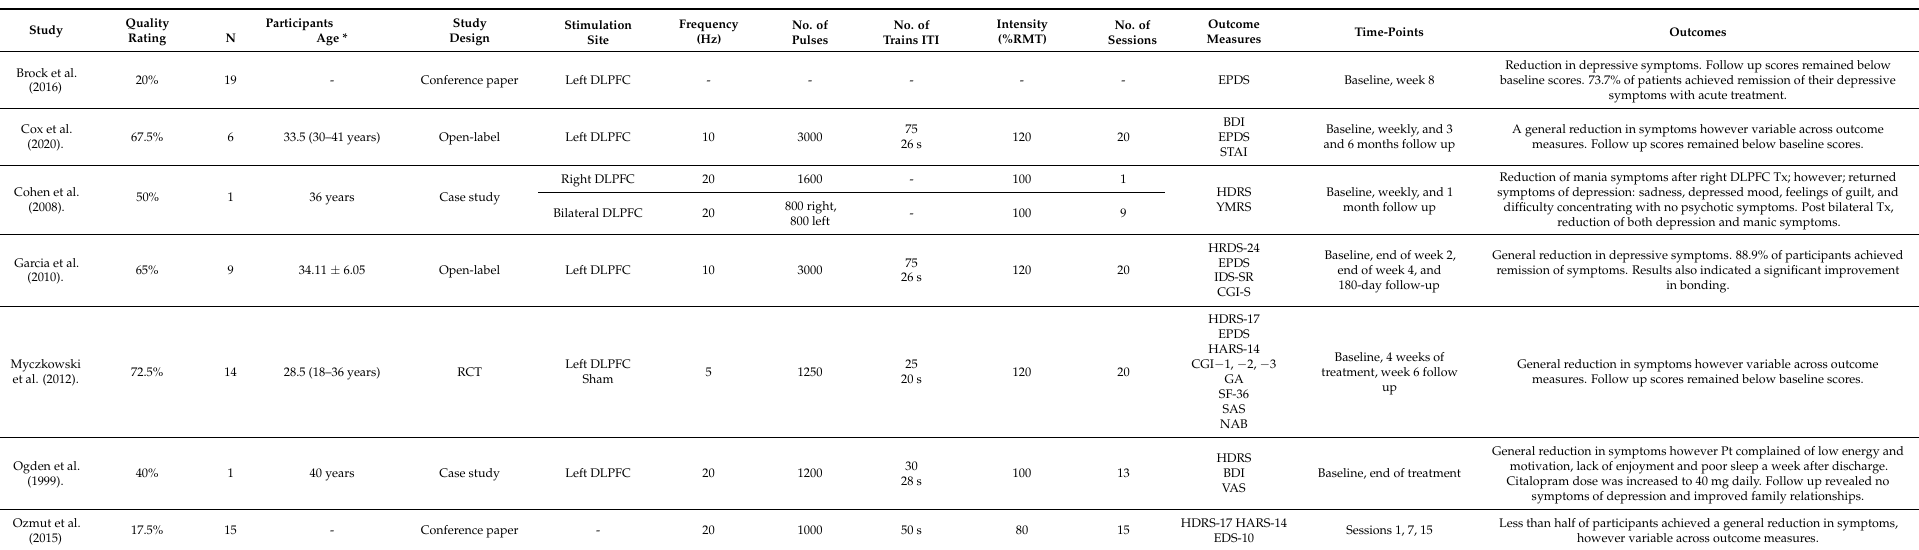
Table 1. Overview of findings from 7 papers including participants and study